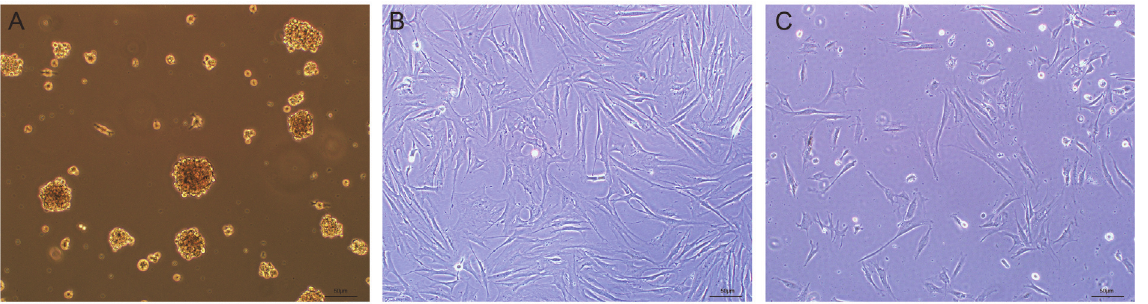
Fig 1. Morphology of SKPs and fibroblasts. (A) SKPs exhibited sphere-like structure in suspension culture.(B) PFBs were typically stellate or spindle shaped.(C) SFBs had the same morphology as